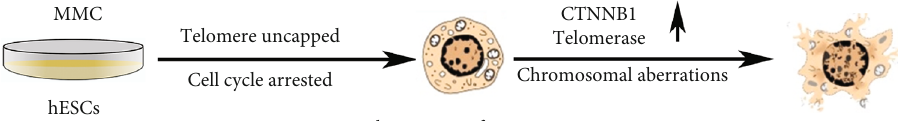
Figure 6: Malignant transformation of